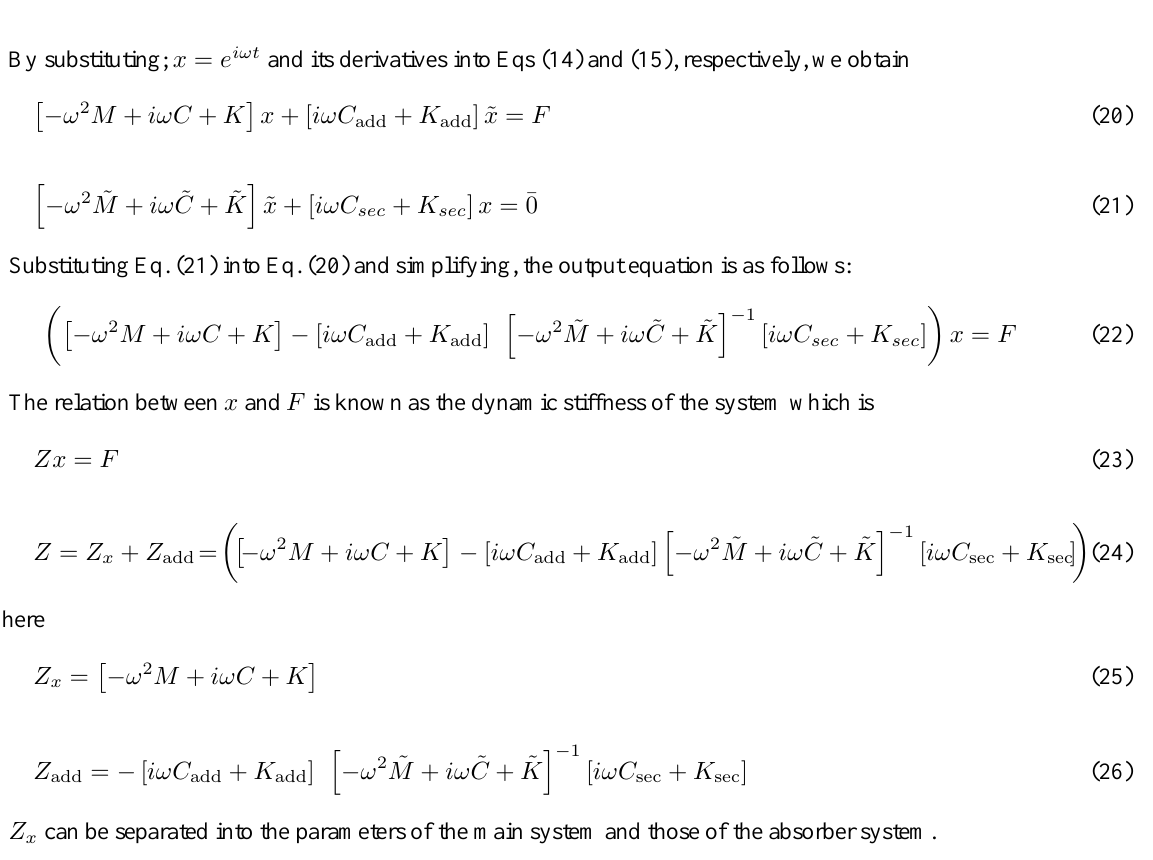
Fig. 9. Displacement of main mass 1, goal function is (0.2x 1 + 0.8x 2 )